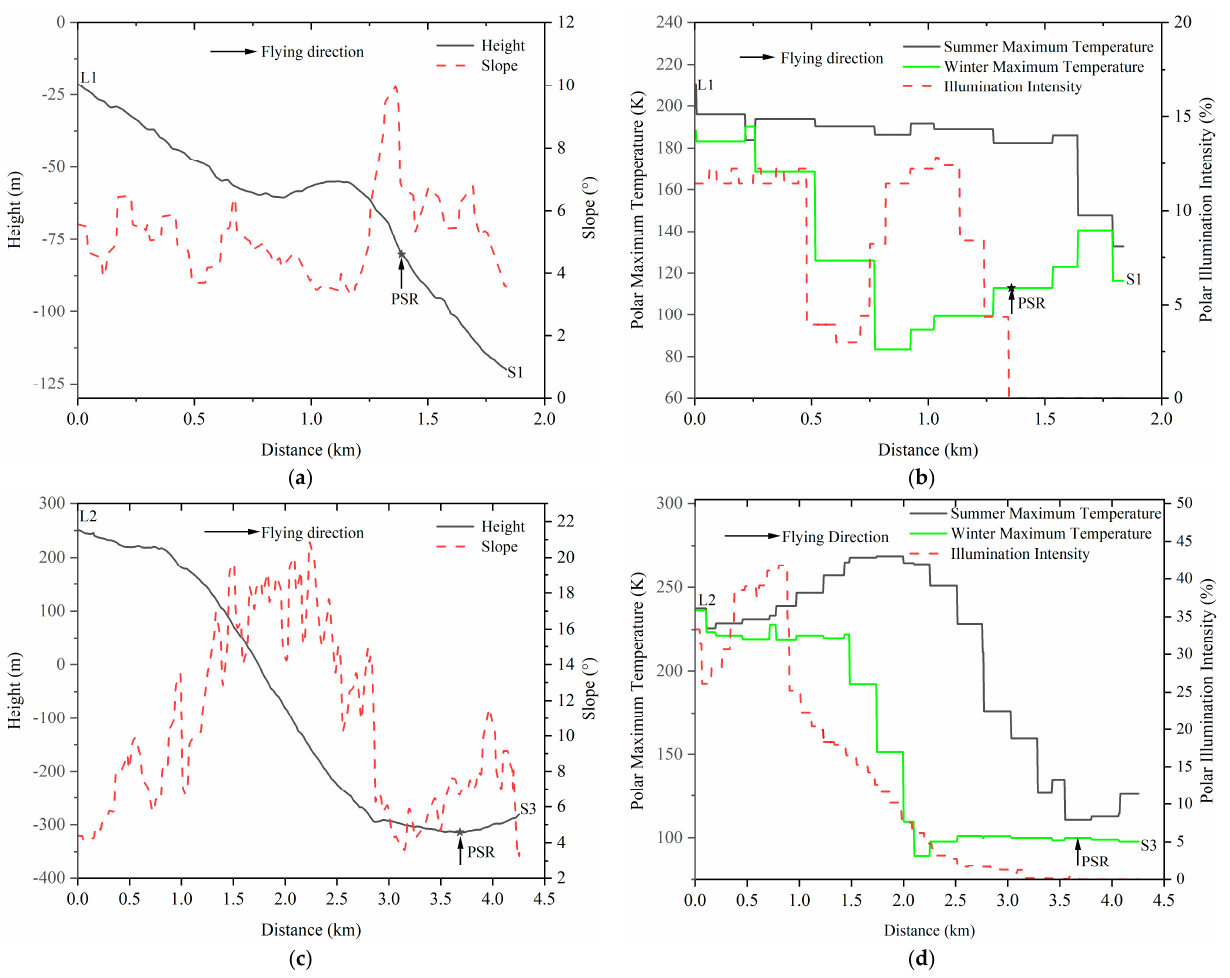
Figure 19. Flight path analysis: ( a ) L1 − S1 height and slope angles along the flight route; ( b ) L1 − S1 polar maximum temperature (summer and winter) and the illumination intensity; ( c ) L2 − S3 height and slope angles along the flight route; ( d ) L2 − S3 polar maximum temperature (summer and winter) and the illumination intensity.